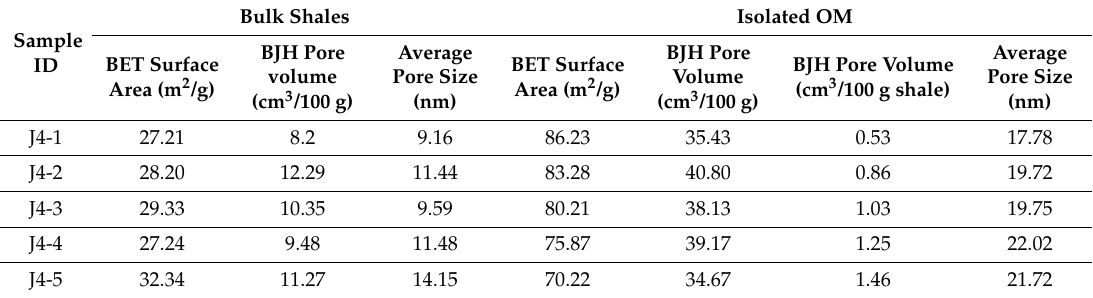
Table 3. Pore structure parameters of isolated OM and shale from low-pressure N 2 adsorption data.